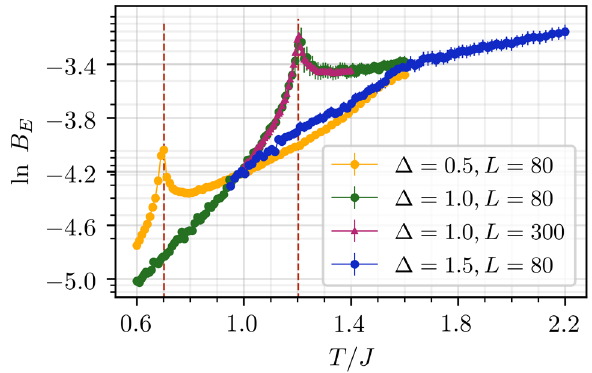
FIG. 8. Binder cumulant of the energy B E ¼ ðh E 4 i = h E 2 i 2 Þ − 1 as a function of the temperature T=J for different values of Δ . The system size is set to L ¼ 80 . At Δ ¼ 0 . 5 , the energy Binder develops a sharp peak at the Potts transition T 3 (vertical dashed line) as obtained in Fig. 4(b). The apparent change in slope at around T ¼ 1 . 5 J coincides with the characteristic broad hump in the specific heat at around 1 . 1 T 6 ¼ 1 . 5 J with T 6 ¼ 1 . 35 J . At Δ ¼ 1 . 0 , the sharp peak associated with the Potts transition has moved up in temperature and is located at T 3 that we extract most precisely from the specific heat (Fig. 6). The presence of a sharp peak, which persists up to the largest system sizes we consider, L ¼ 300 , is a clear indication of a Potts transition at Δ ¼ 1 . 0 .